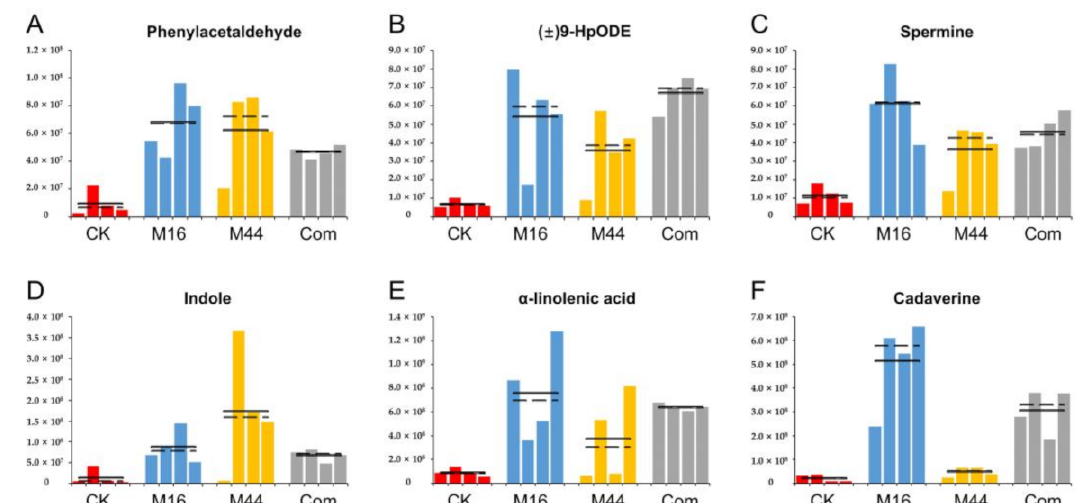
Figure 6. Histograms of plant growth-regulating molecules, phenylacetaldehyde ( A ), ( ± )9-HpODE ( B ), spermine ( C ), indole ( D ), α -linolenic acid ( E ), and cadaverine ( F ), based on quantitative statistics. CK: control; M16: M16 treatment; M44: M44 treatment; Com: combination of M16 and M44. Solid and dashed lines represent the means and medians of the contents of metabolites in CK, M16, M44, and Com,